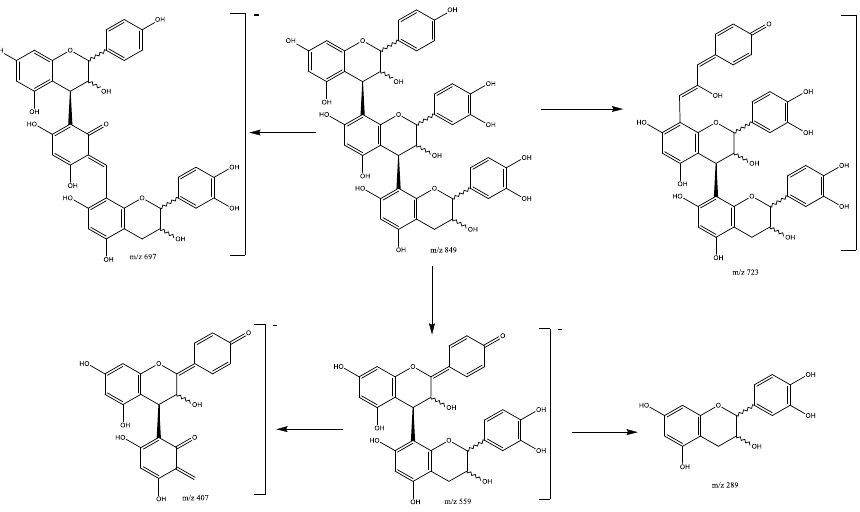
Figure 10. Propelargonidins (epi)afzelechin-(epi)catechin-(epi)catechin B-trimers fragmentation pathway.